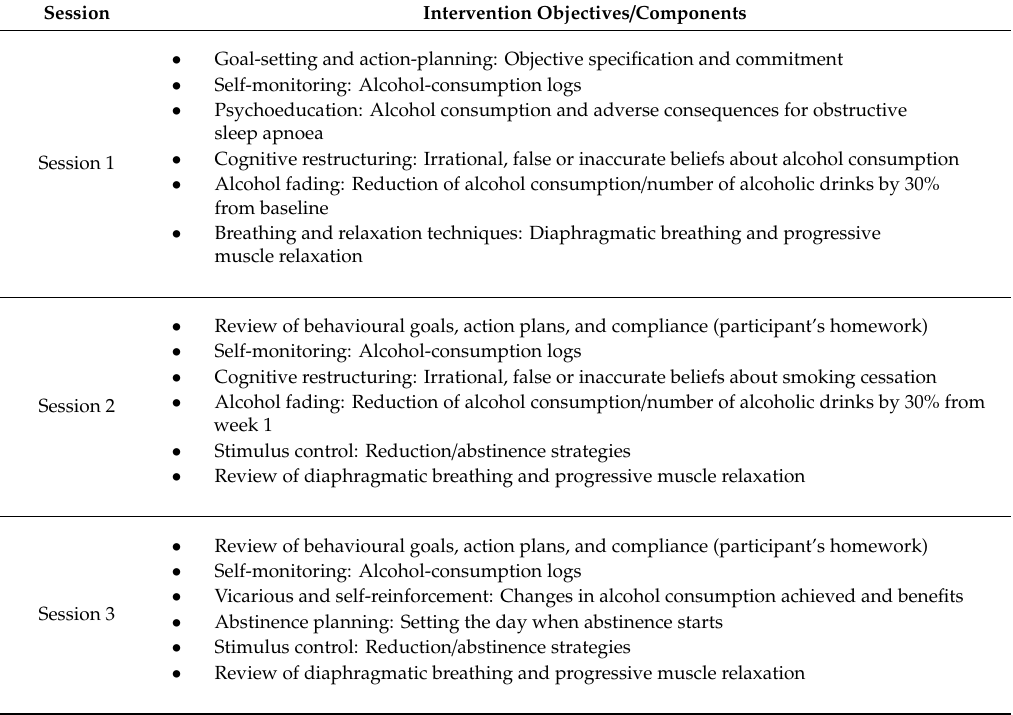
Table 7. Summary of components of the alcohol avoidance module per